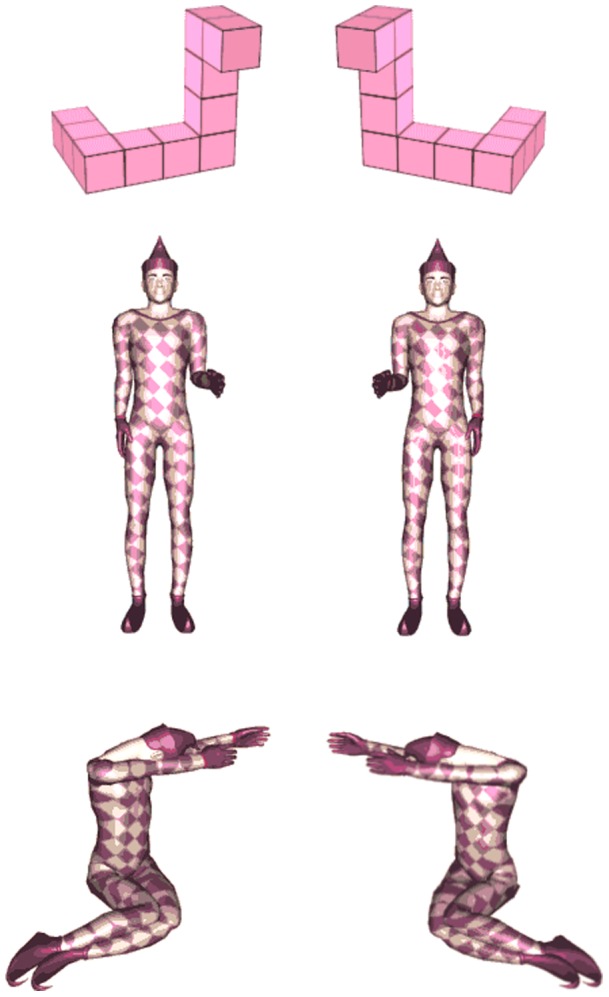
Sample items of the chronometrical mental rotations tasks (cube figures, human figures, body postures).